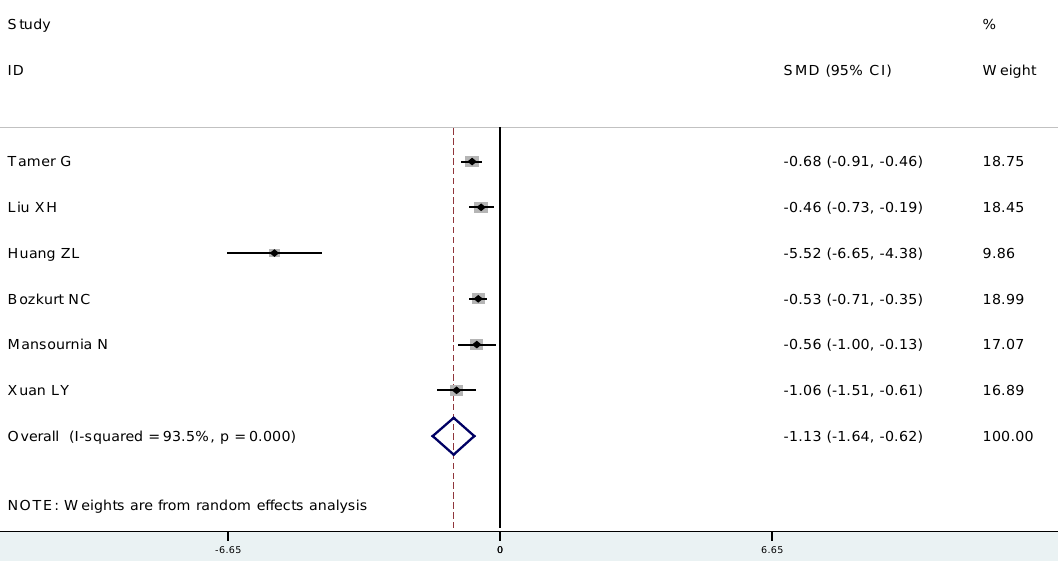
Figure 5. Meta-analysis of studies (chronologically ordered) reporting dichotomous outcomes of 25(OH)D levels in Graves’ disease vs. controls and estimated ORs with 95% confidence interval.